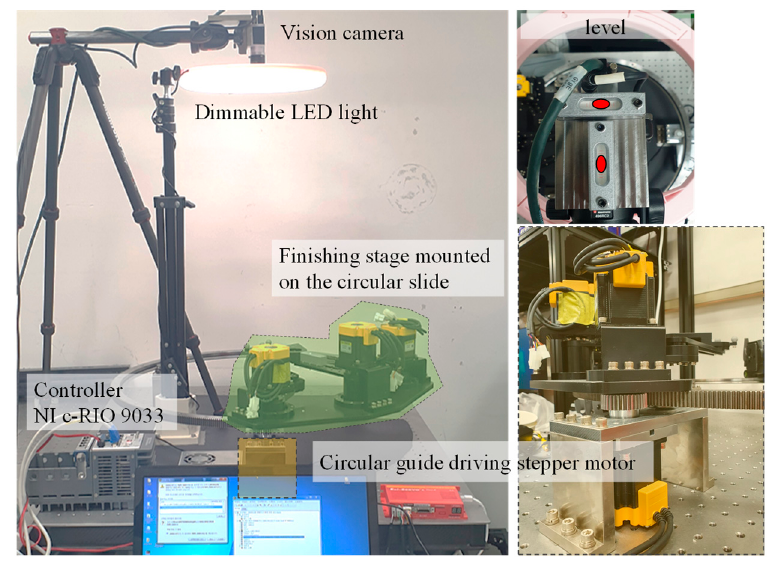
Figure 14. Snapshot of the experimental environment. ( left ) Side view; ( right ) top view of the vision-camera part with two levels.